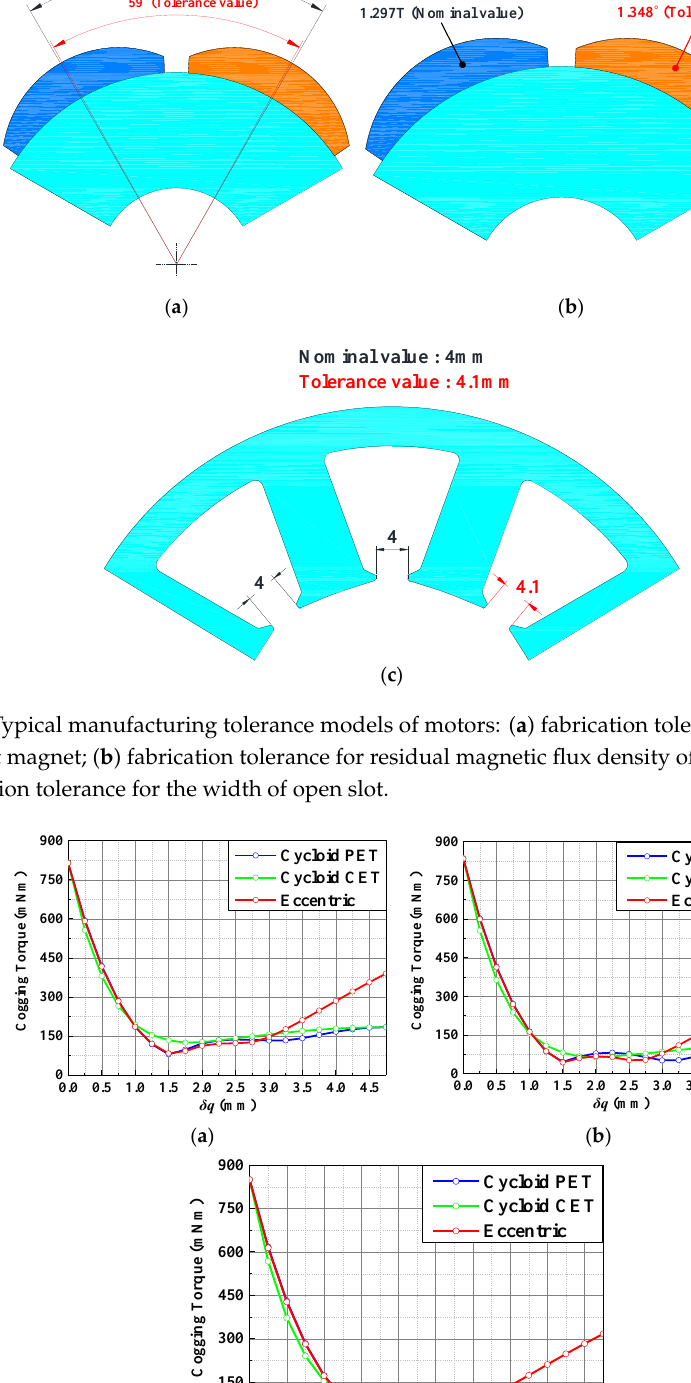
( c ) Figure 8. Cogging torque according to δ q of each curve: ( a ) trend in cogging torque according to δ q ; ( b ) TIR of cogging torque (@ Δ δ q = 1.5); ( c ) TIR of cogging torque (@ Δ δ q = 3.25). As shown in Figure 8 (a), the tendency of the cogging torque differs above and below δq = 1.5. At δq < 1.5, the cogging torque decreases rapidly as δq increases. At 1.5 < δq < 3, the magnitude is similar to that at δq = 1.5. At δq > 3, the eccentricity curve increases the cogging torque greatly as δq increases. However, both cycloid curves maintain similar values. CT TIR pp q CoggingTorque    (12) Figures 8 (b) and (c) show the TIR of the cogging torque for Δ δq = 1.5 and Δ δq = 3.25, respectively. The TIR of the cogging torque is obtained from (9). At Δ δq = 1.5, the TIR of the cogging torque is a large negative value. Also, the magnitude of the TIR is similar for all curves. However, at Δ δq = 3.25, a different trend is observed (i.e., the cogging torque TIR of the eccentricity curve is largest). The cogging torque TIR of eccentricity is about four times that of PET and about six times that of CET. At Δ δq = 3.25, the cycloid curve has a smaller performance variation of cogging torque than does the eccentricity curve owing to fabrication tolerances. Therefore, the analysis of the performance variation owing to manufacturing tolerances was performed at Δ δq = 3.25.